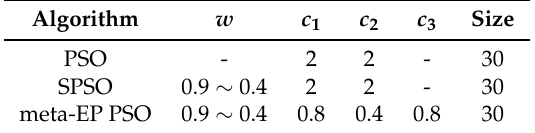
Table 3. The configuration parameters of the PSO, SPSO, and meta-EP PSO algorithms.